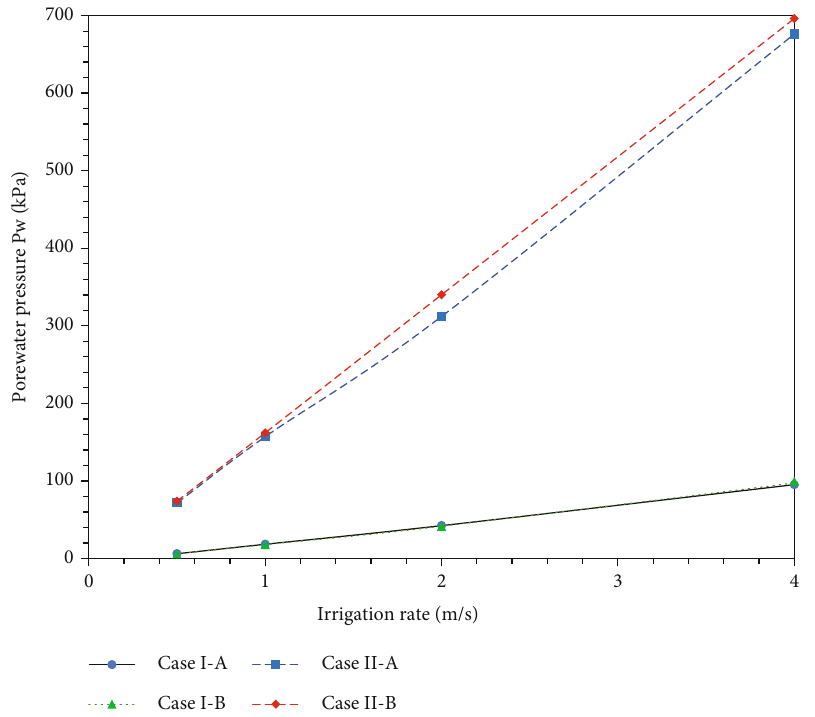
Figure 13: Peak porewater pressure (pw) in the system.